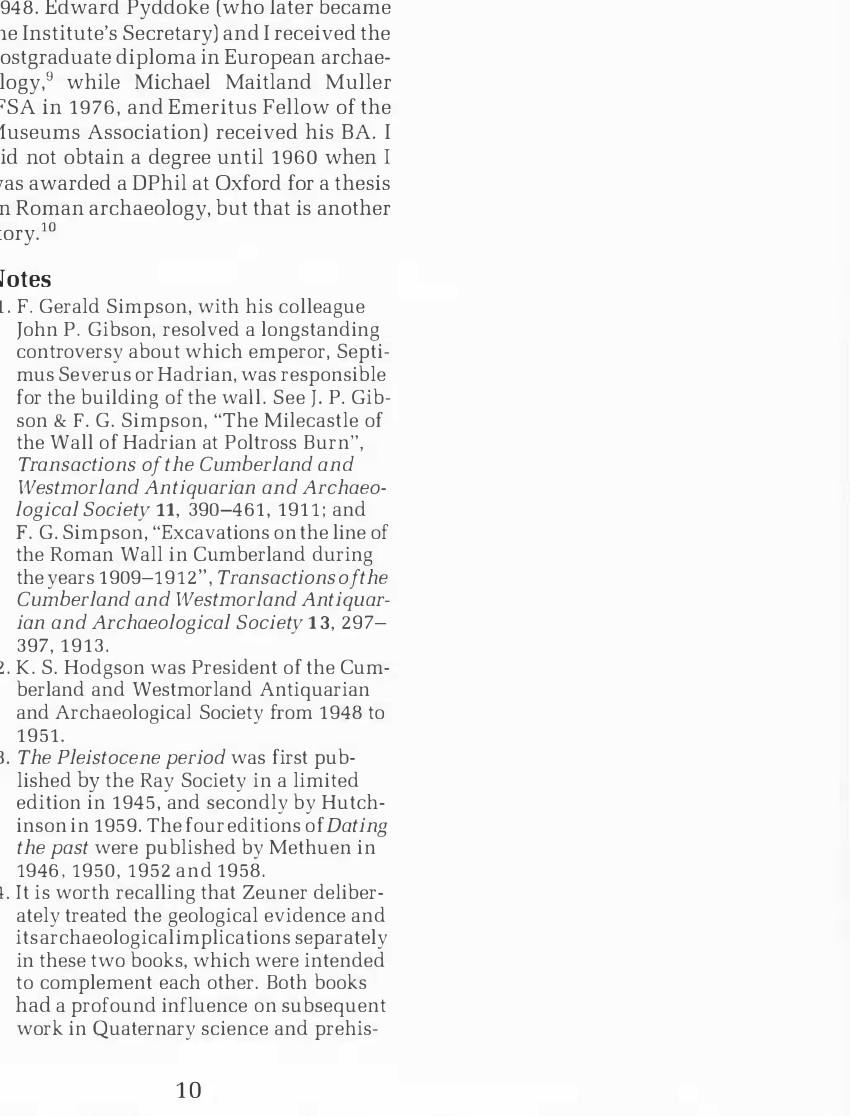
Figure 3 The west front of St John's Lodge, Regent's Park, June 1936 (the year before the building was formally opened as the Institute of